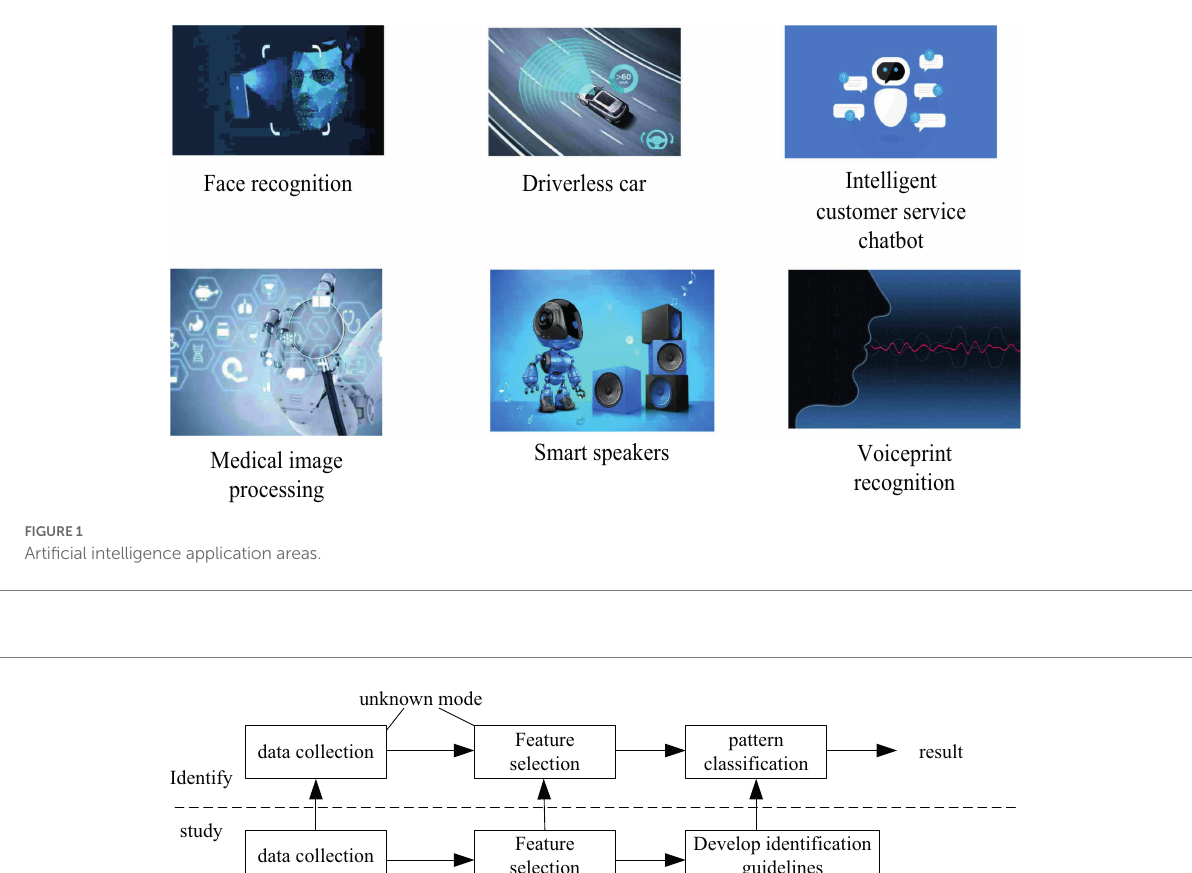
FIGURE 2 Pattern recognition